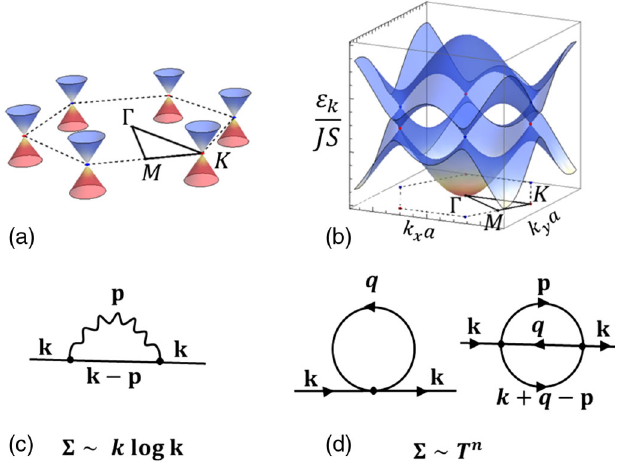
FIG. 1. Comparison of Dirac fermions (left panels) vs bosons (right panels). (a) The properties of the Dirac fermion materials are determined by the states at the chemical potential. So, approximating the band structure by the Dirac cones near the zone centers is sufficient. (b) In contrast, since bosons can freely occupy any states within the Brillouin zone, information about the entire band structure is necessary. In the top panels, the color scheme (red to blue) is an artistic representation of the particle occupation number from strong to weak. Temperature can efficiently excite the bosons in the down-band in the vicinity of the Γ point. (c) The relevant self-energy diagram that gives the logarithmic correction to the Dirac fermion velocity. (d) The relevant self-energy diagrams giving a temperature-dependent renormalization and decay of the Dirac